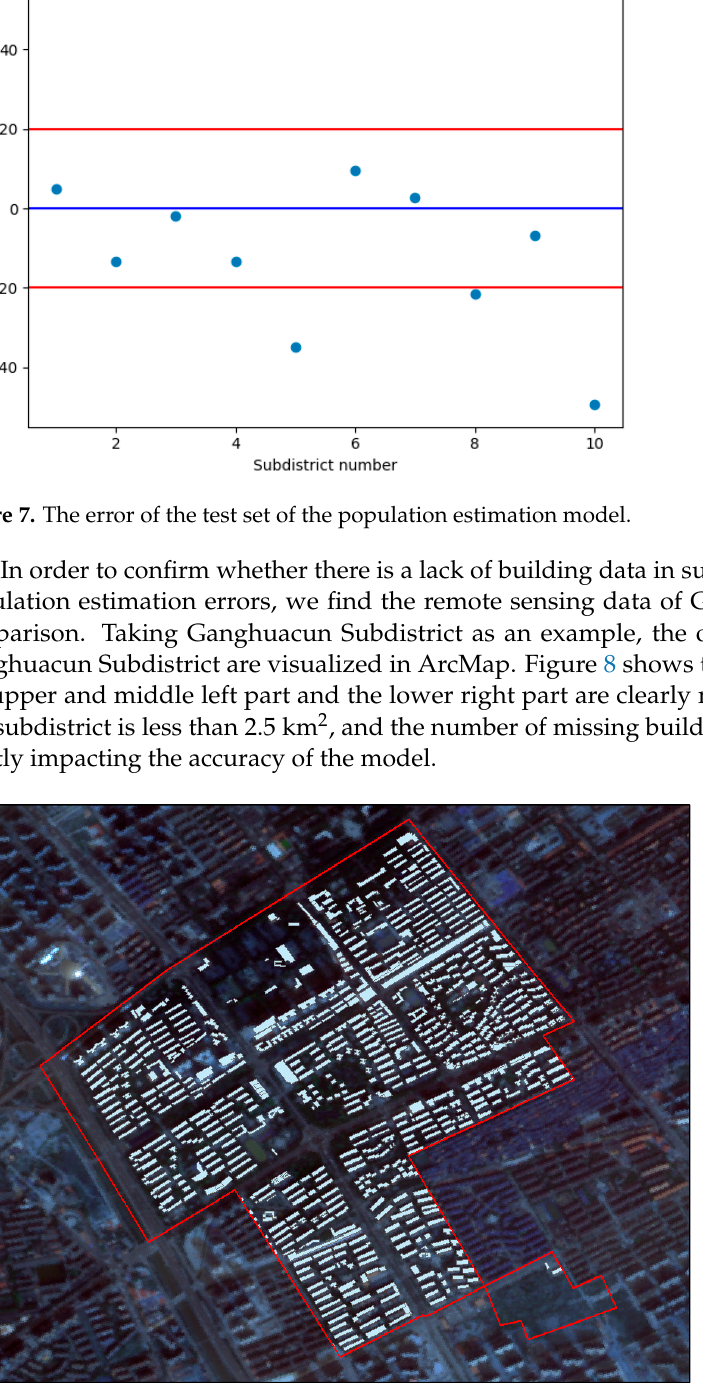
Figure 8. Buildings in Ganghuacun Subdistrict.